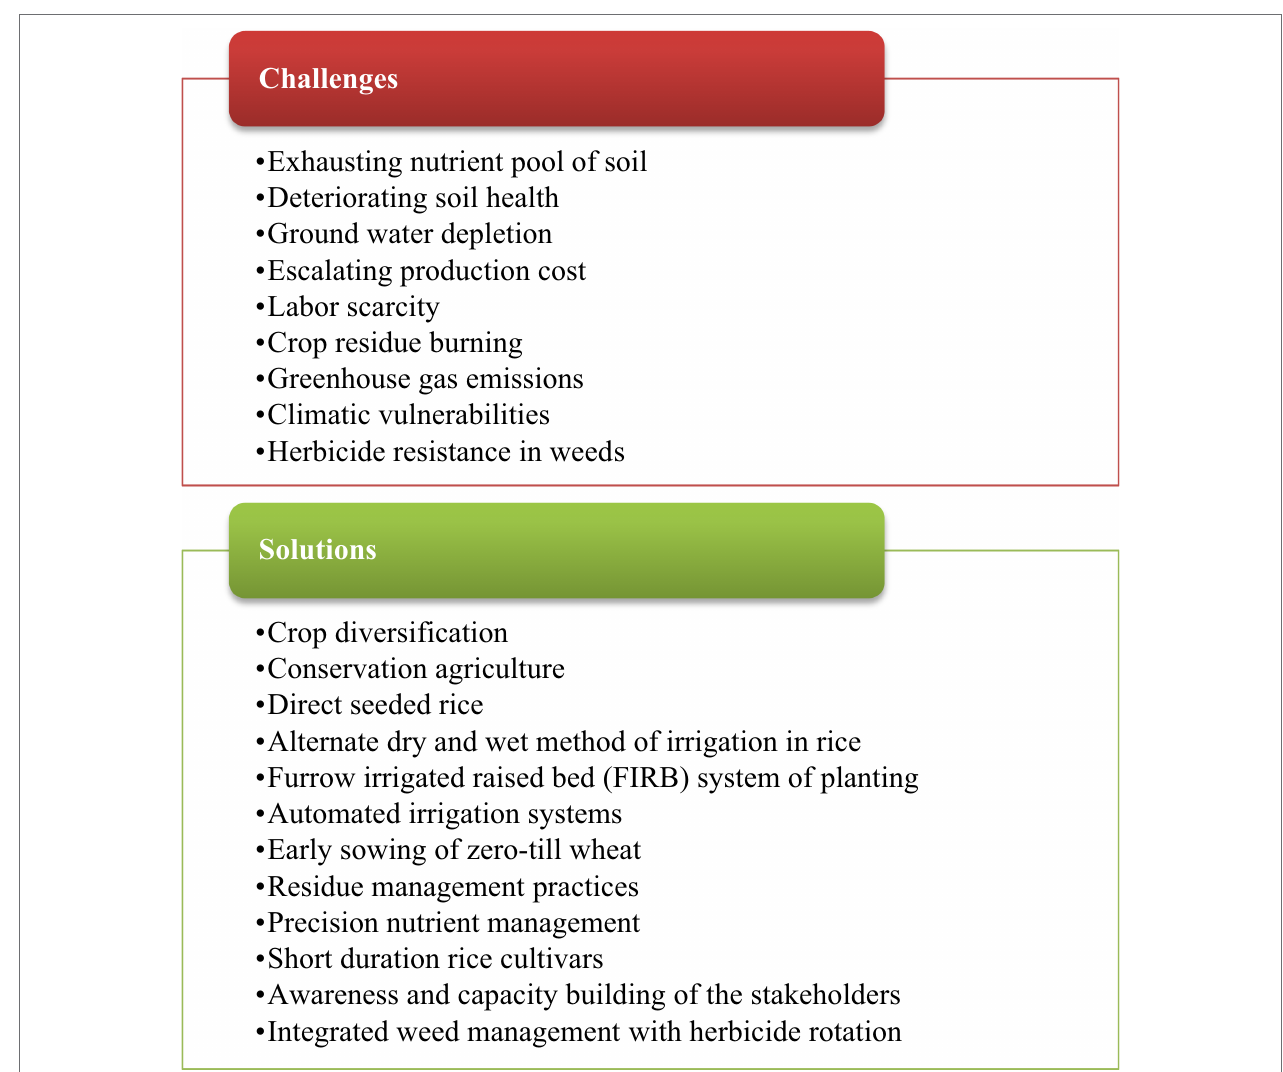
FIGURE 1 | Challenges of the rice–wheat cropping system in northwest India with proposed